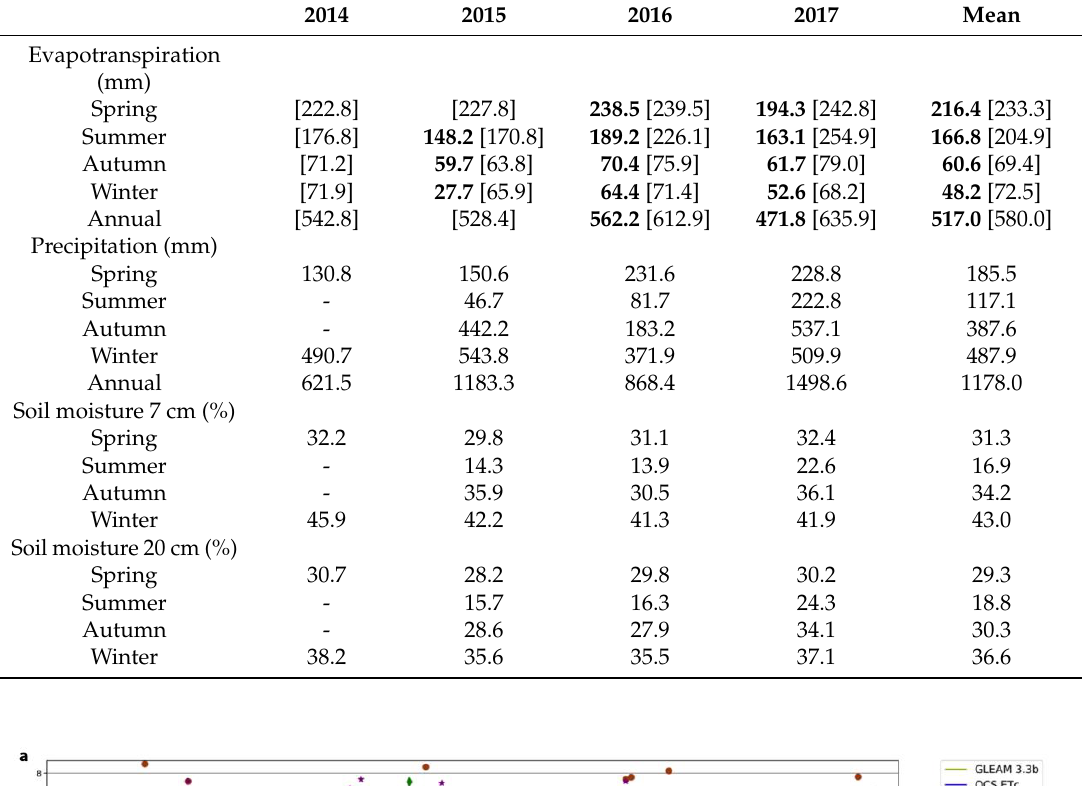
Table 1. Seasonal evapotranspiration (mm), precipitation (mm) and soil moisture (%) in Oromo over the period 2014 – 2017. In-situ evapotranspiration (bold) and the corresponding estimate from the PML_V2 global product (brackets) are given for annual and austral spring (September – November),